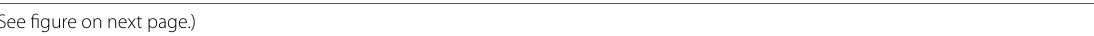
(Fig. 3c, d) nearly matched the given slip distribution (Fig. 3a, b). Distribution of the standard deviation of the estimated slip in the two orthogonal directions at each subfault is shown in Fig. 3e, f. The standard devi- ation was used as a reference to evaluate the estima- tion error of slip obtained in each subfault. It can be seen that the standard deviation is relatively small in the region where many observation points are distrib- uted. We calculated the total seismic moment using only subfaults with slips larger than the 1- σ estima- tion error in this study. The calculated total seismic moment of 1.45 10 18 N m ( M w 6.04) was almost × = equal to the given seismic moment of 1.41 10 18 N m × ( M w 6.03). A rigidity of 4.0 10 10 N = ×